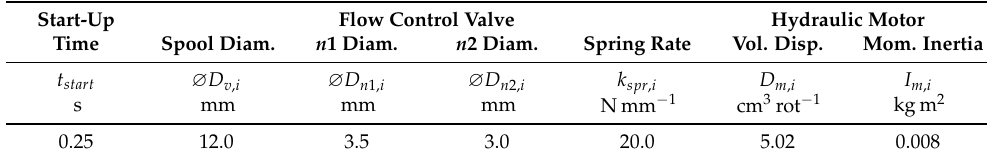
Table 5. Fixed values of simulation model parameters.